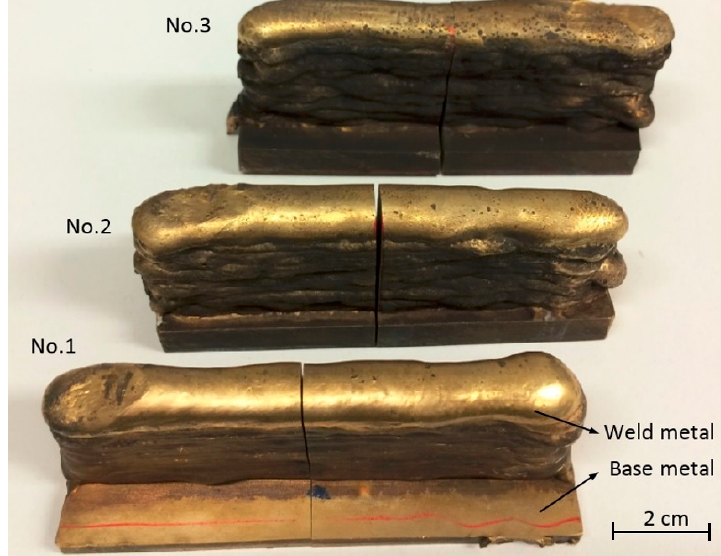
Figure 3. Three additively-manufactured NAB components. The deposited wall components were wire-cut from the middle in the lengthwise direction with one half of the walls further processed with post-weld-heat-treatment. Table 1. Composition of NAB-based metal and welding wire (wt %).